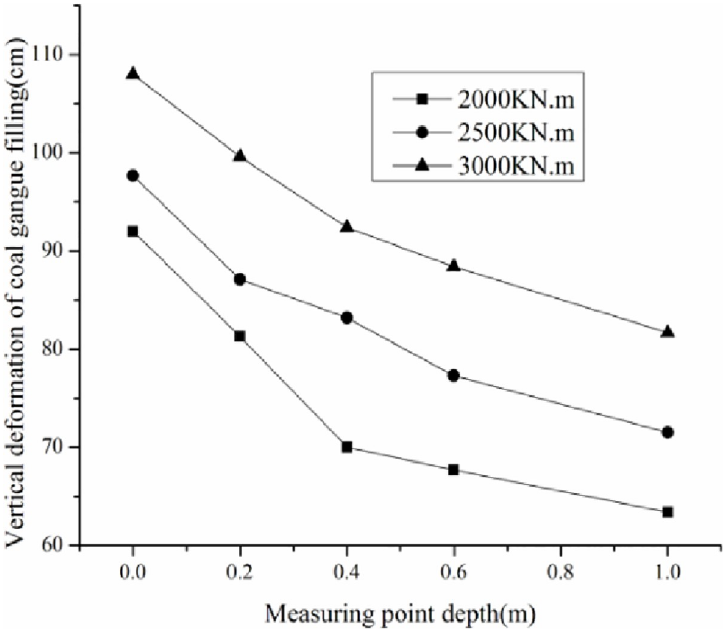
Fig 10. Vertical deformation curve of the goal gangue filling under different tamping